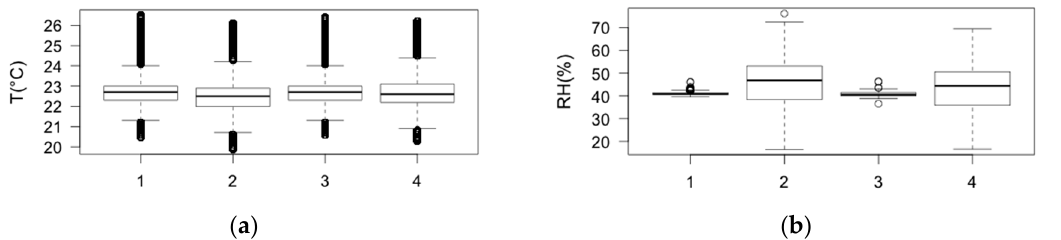
Figure 3. Box-and-whisker plot of T ( a ) and RH ( b ) inside (probes 1 and 3) and outside (probes 2 and 4) the microclimate frames. The outliers, i.e., the values above or below 1.5 × IQR (IQR = interquartile range), are indicated with a circle.